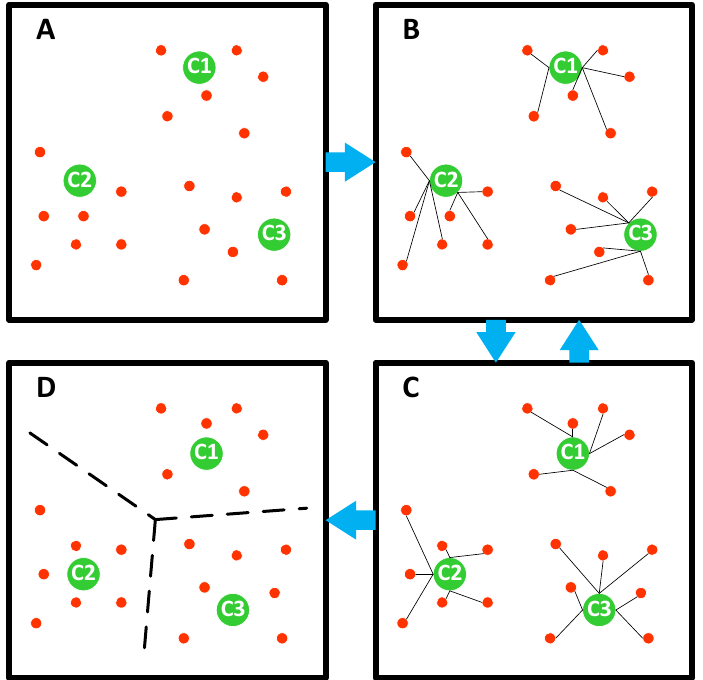
Figure 4. The process of K-means clustering. ( A ) The initial cluster centers are randomly selected. ( B ) Calculate the distance between the sample and the cluster center and classify samples. ( C ) Reselect cluster centers. ( D ) The clustering result is confirmed.